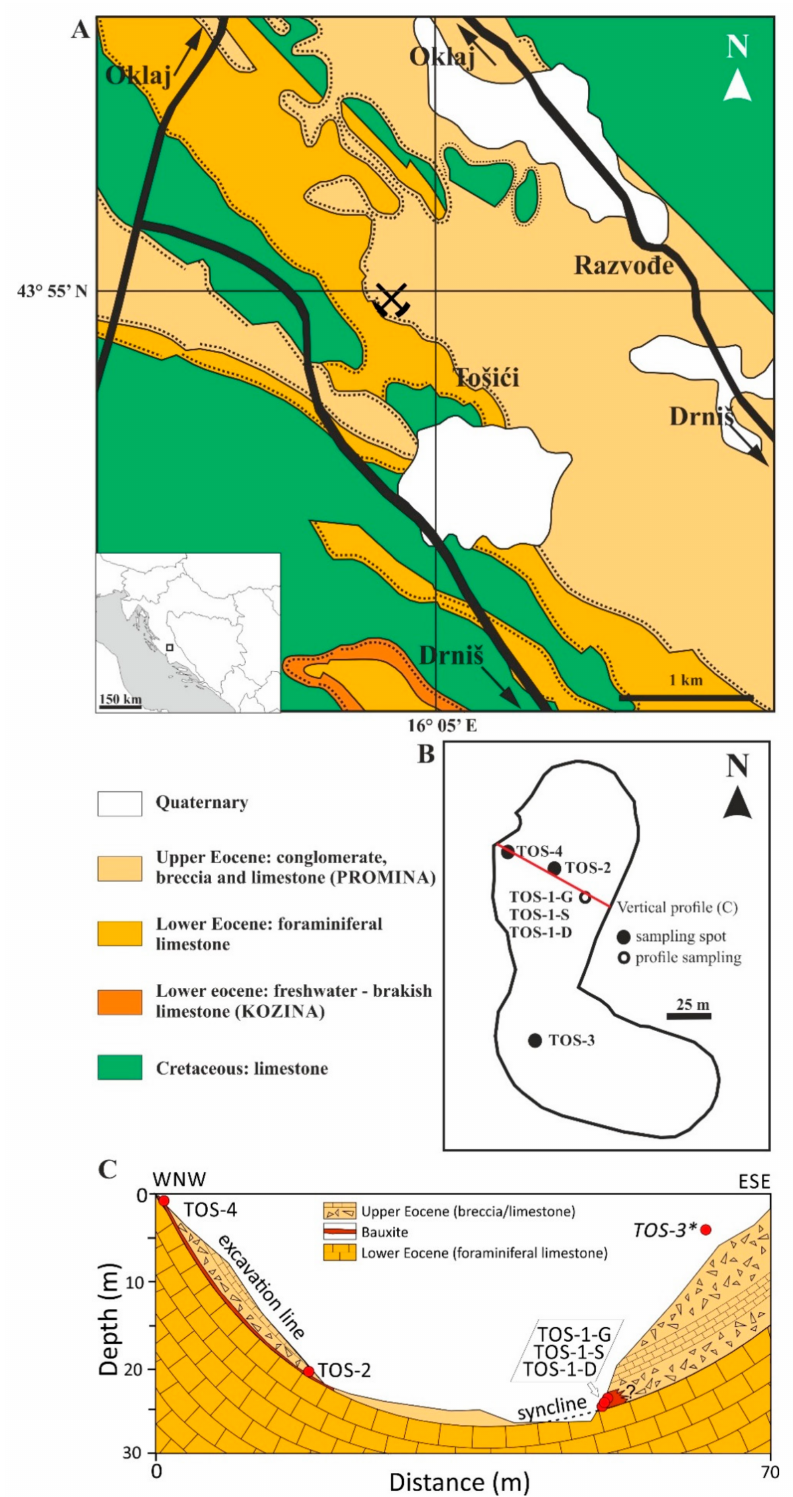
Figure 1. Situation and lithostratigraphic map (after [15]) for the Toši´ci-Duji´ci deposit area (the deposit pit is marked with abandoned mine symbol in the map) ( A ), ground sampling plan ( B ), and vertical profile outline of exploitation pit along WNW-ESE direction indicating sampling positions (* TOS-3 was collected at the indicated position situated 80 m away from the profile towards SSW) ( C